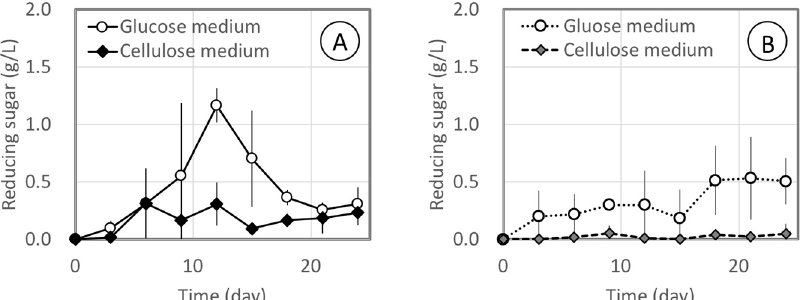
Figure 3. Relative cellulase activities by F. palustris NBRC 30339 in glucose medium and MCC medium. Cellulase activities were estimated by measuring reducing sugar released from CMC ( A ) and MCC ( B ). All experiments were conducted under semi-anaerobic conditions.